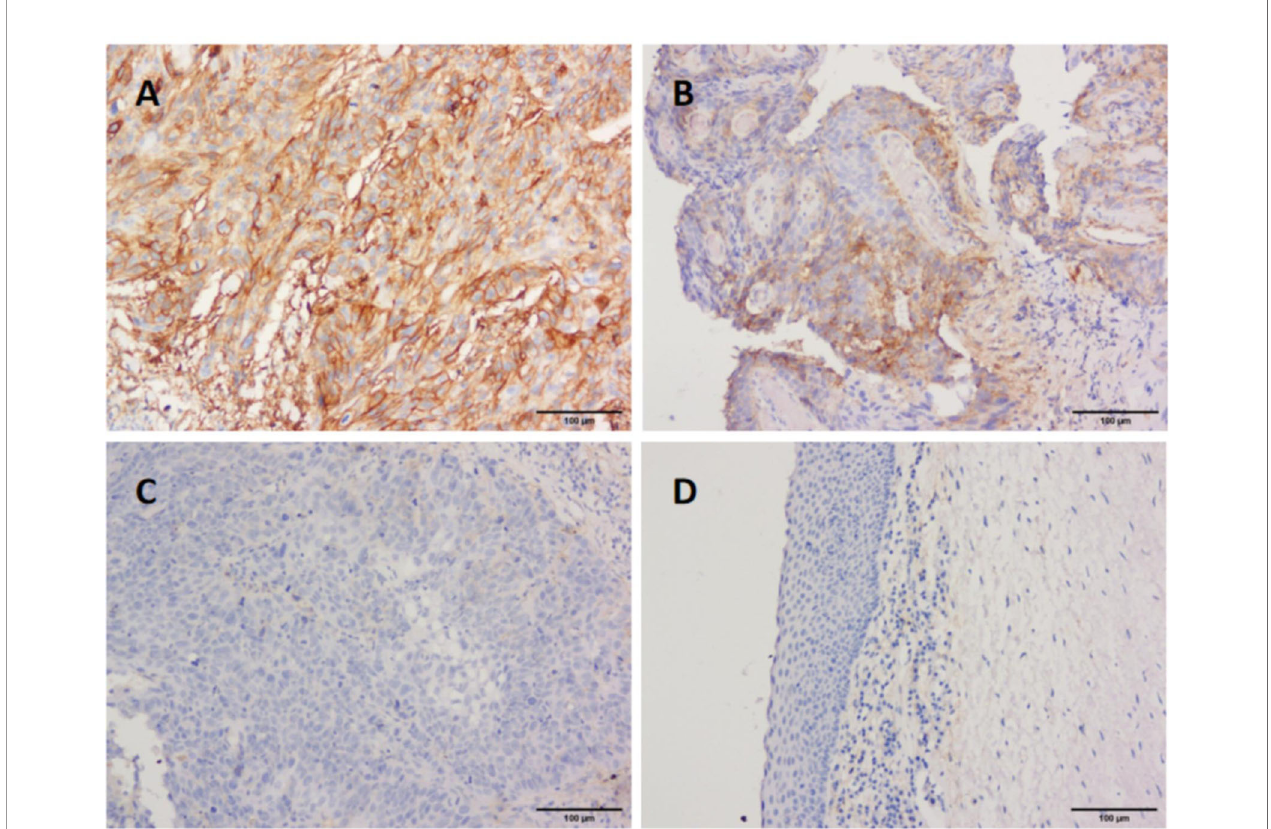
FIGURE 3 | Immunohistological staining of LSCC tissues for B7-H3 expression. Representative tissues of, strong staining (A) , moderate (B) , weak (C) , and adjacent normal tissues (D) for B7-H3 expression in LSCC samples. (magni fi cation